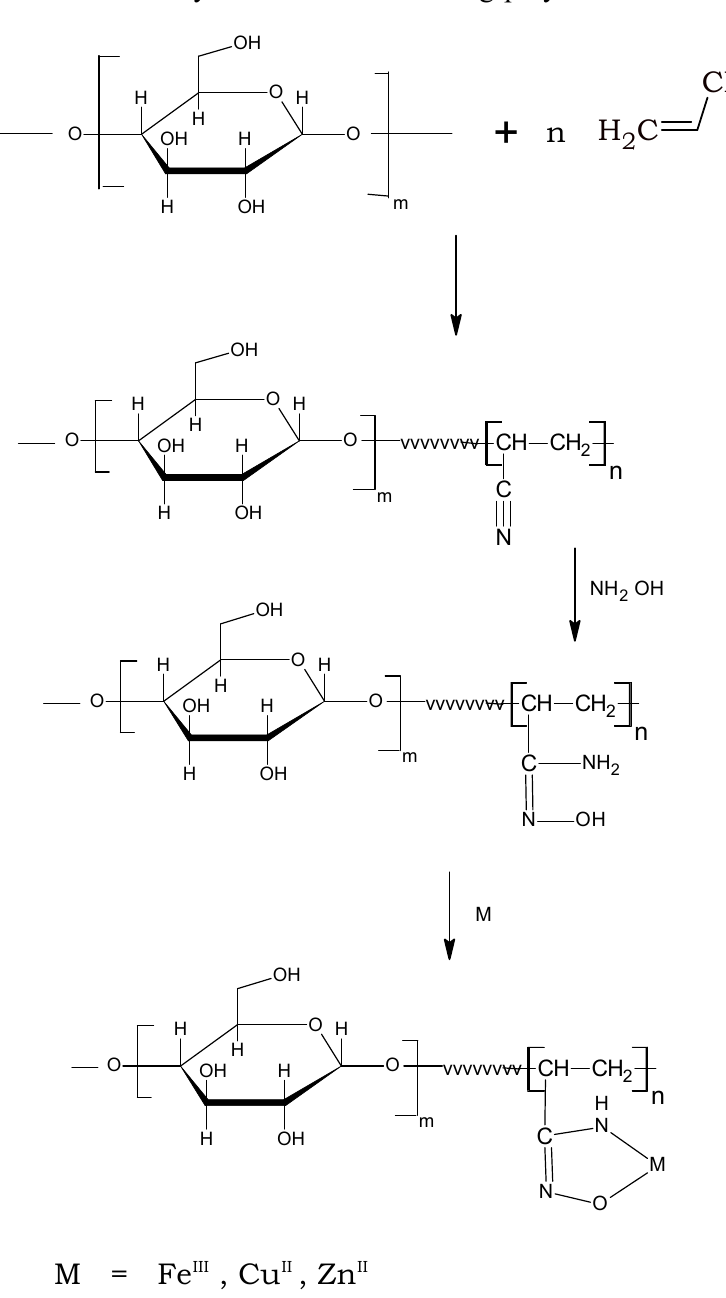
Scheme 1. Synthetic route to